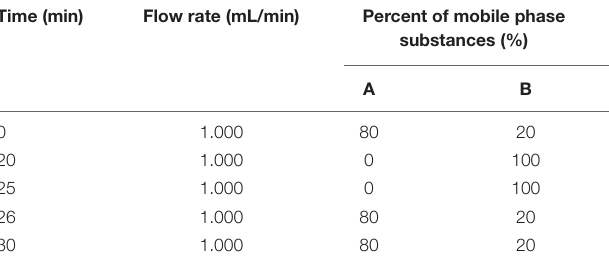
TABLE 1 | Gradient elution program for neohesperidin content